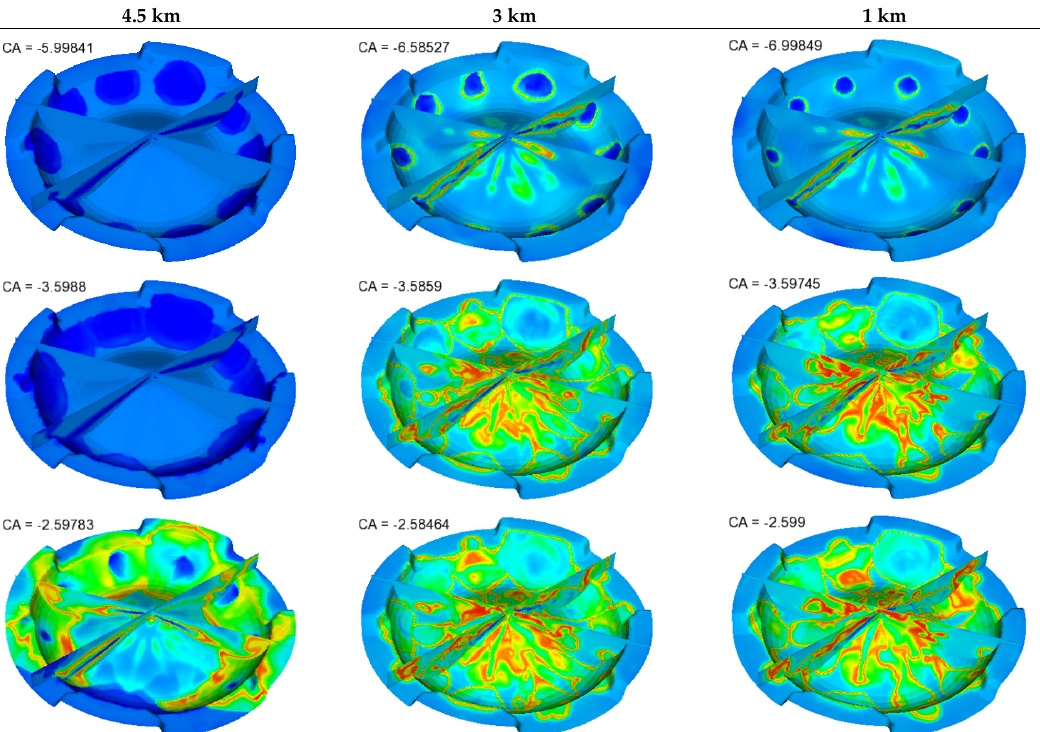
Figure 18. Ratio of mass of fuel vapor/injected fuel at various altitudes.